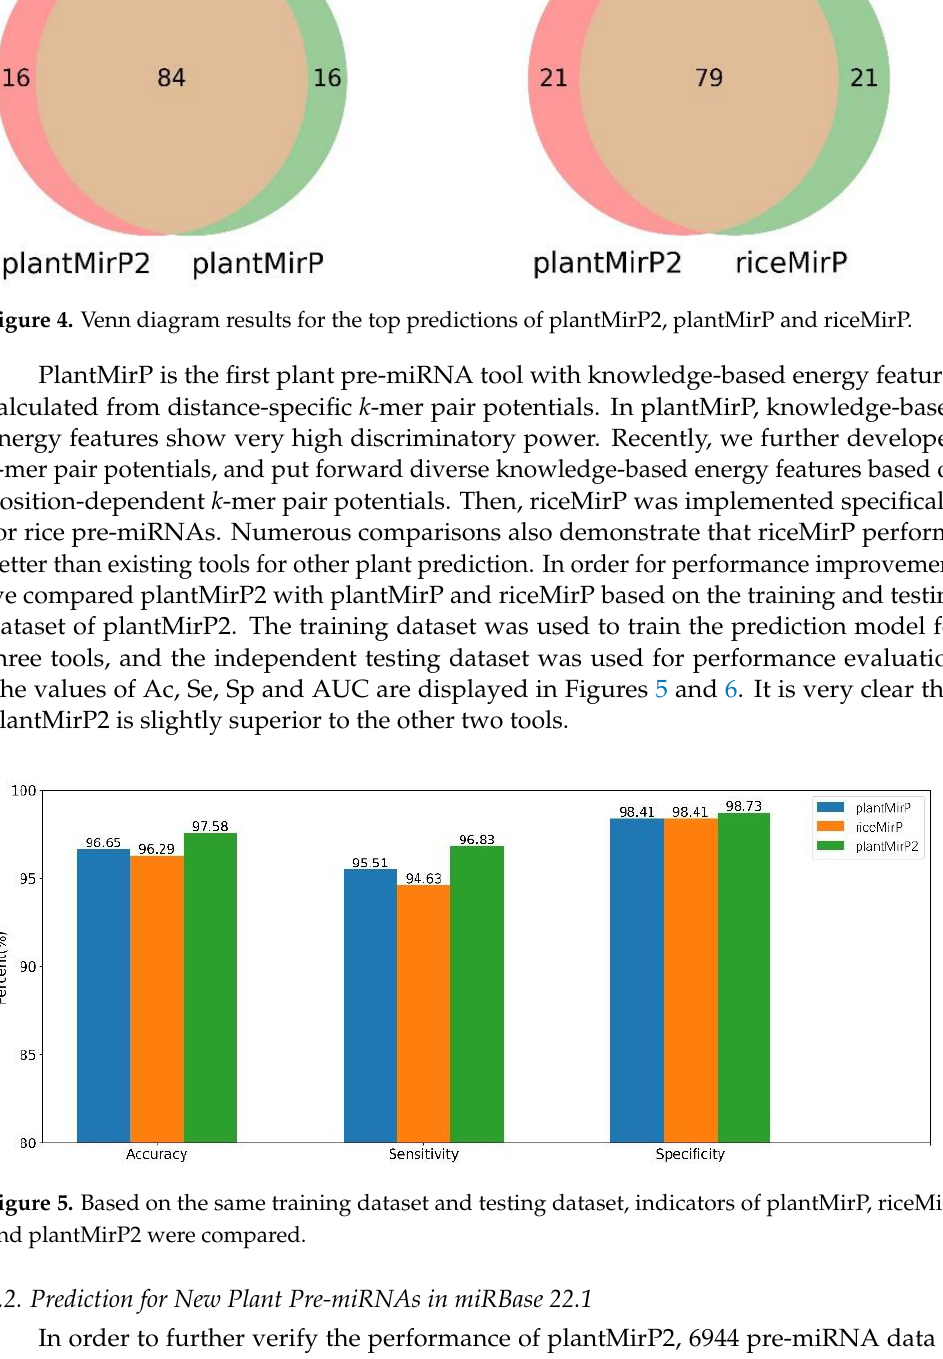
Figure 3. ROC (Receiver Operating Characteristic) curves and corresponding AUC (Area Under Curve) values of the 4-, 6-, 8- and 10-fold CVs (Cross-Validations) based on the training dataset and the independent testing dataset.